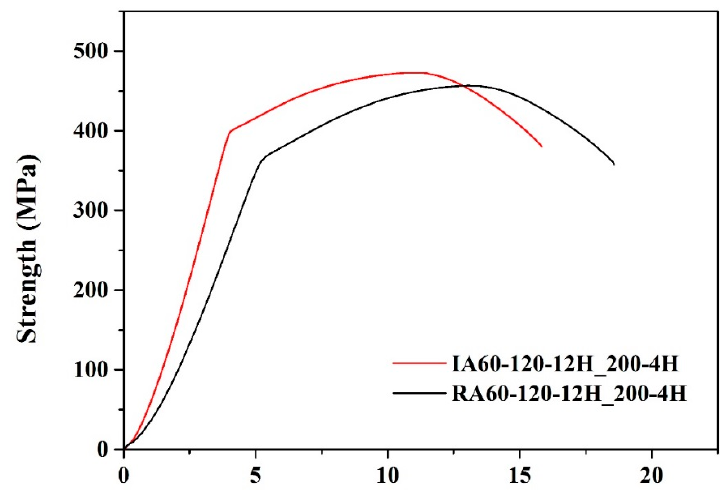
Figure 12. Strain-stress curves of specimens after the high-temperature test (200 °C, 4 h). Table 7. Specific tensile strength, elongation, and hardness of high-temperature (200 ° C) over-aged specimens.